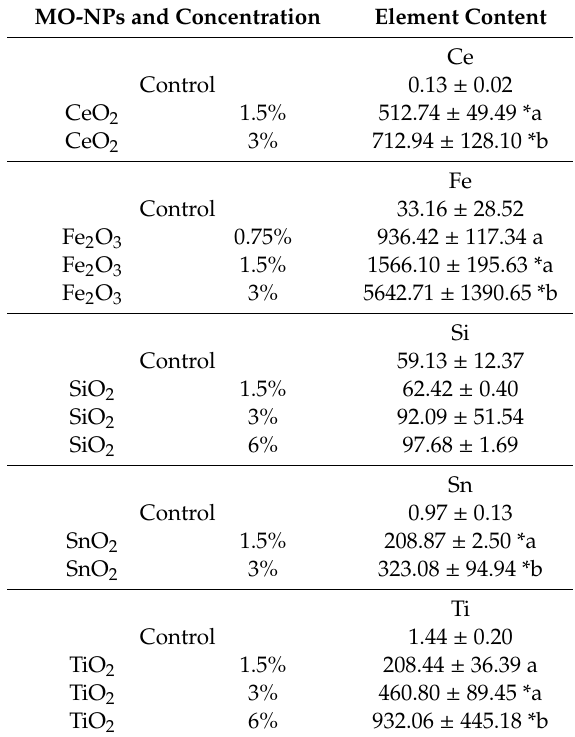
Table 2. Content of Ce, Fe, Si, Sn, and Ti (ppb in extracts) in oakleaf lettuce seedlings depending on engineered nanoparticles (nano-metal / metalloid oxides; MO-NPs) applied to the leaves at di ff erent concentrations. Control plants were sprayed with deionized